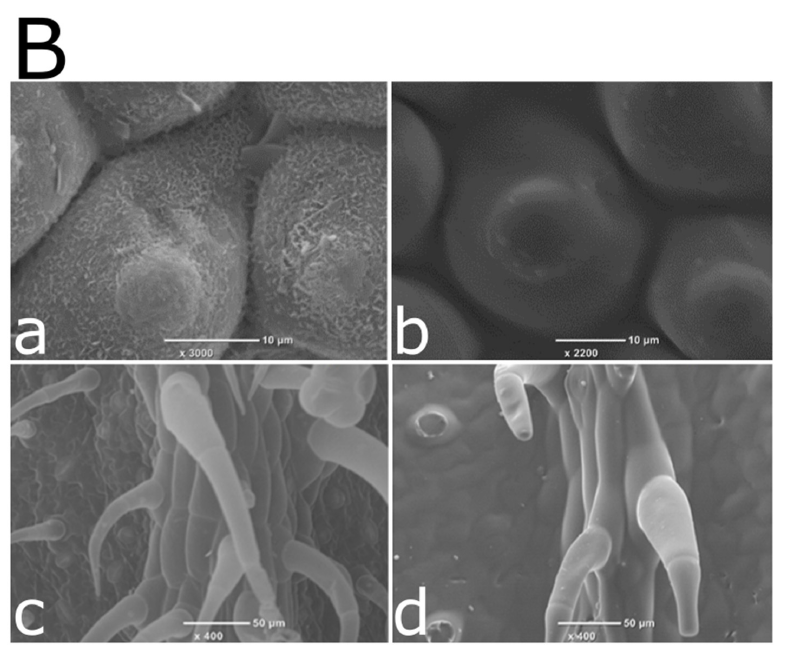
Figure 2. Replication of C. esculenta and tomato leaves microstructure. ( A ) Schematics of the replication process. A leaf was glued to a petri dish and dehydrated ( a ). Soft polymer was applied onto the leaf and cured in an oven ( b ). The leaf was carefully peeled off the negative mold ( c ). Negative mold was submerged in a digestion solution, and any leaf traces were removed ( d ). Negative mold was dried and treated with plasma, and then soft polymer was applied to the mold ( e ). Leaf replica was cured at rooms temperature and carefully peeled off the negative mold ( f ). ( B ) SEM micrographs of C. esculenta leaf ( a ) and its PDMS replication ( b ), tomato leaf ( c ) and its PDMS replication ( d ). Leaves were fixated and underwent CPD, as described in the methods section. The leaves were then coated with a thin layer of gold and visualized using SEM at a high resolution. Replicas were coated and visualized by SEM. The images show good replication quality of leaf microstructure.